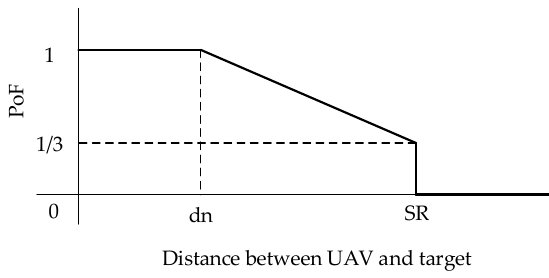
Figure 4. The calculation on PoF (profit of follow) contribution by a